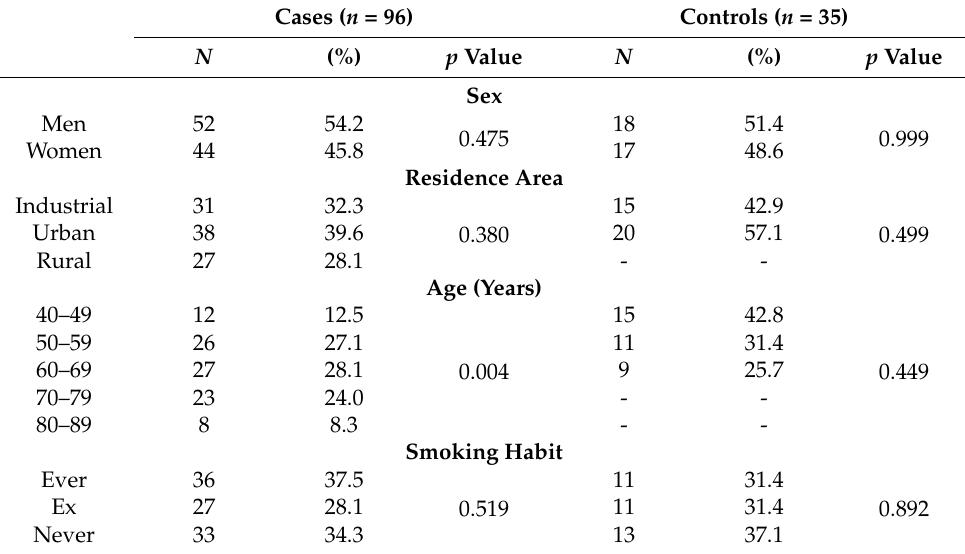
Table 3. Demographic characteristics and smoking status for controls and